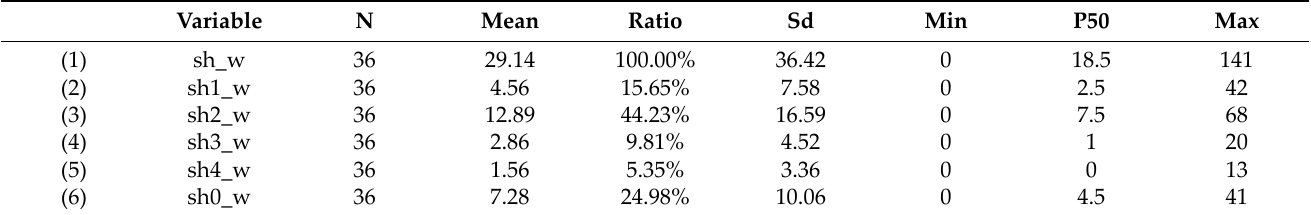
Table 9. Results of shareholder level‑2 subdimension analysis on social